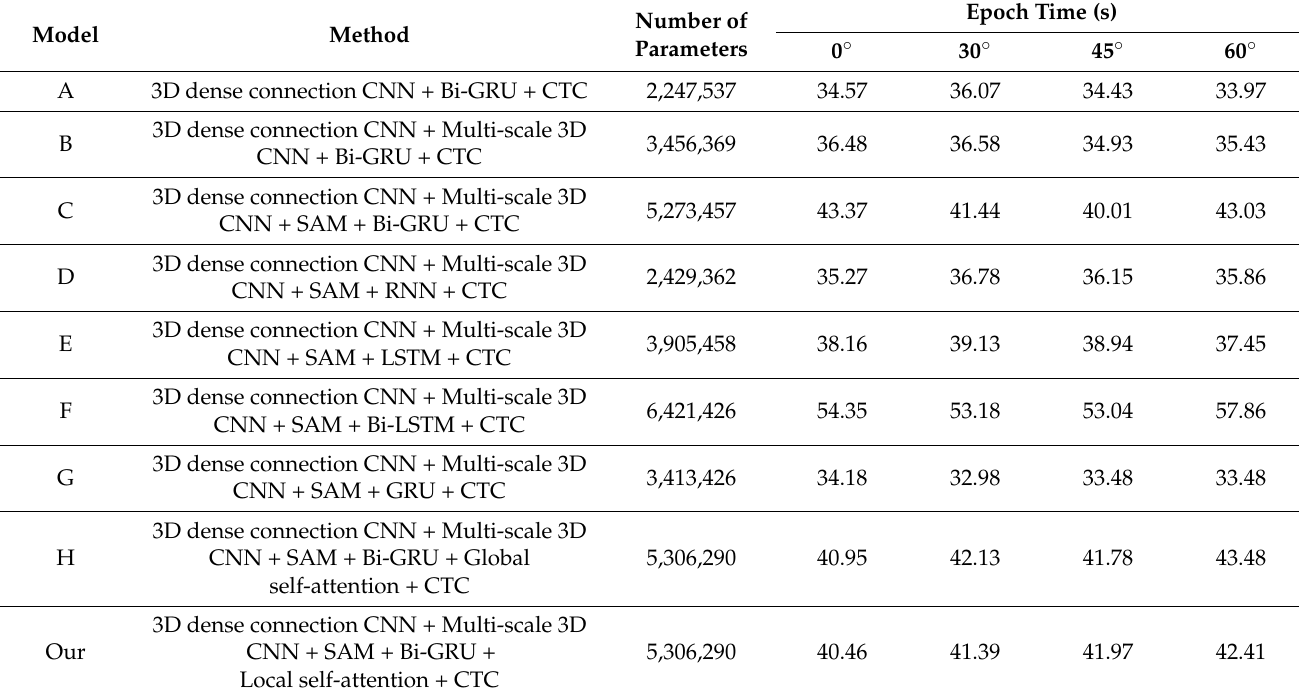
Table 4. Comparison between the number of parameters and epoch times of the proposed method and different